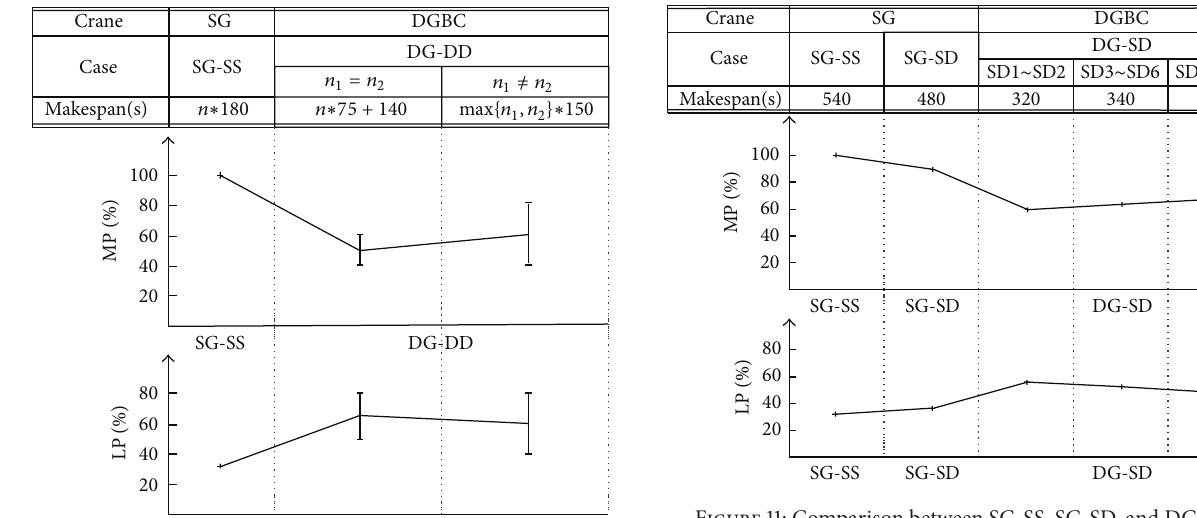
Figure 11: Comparison between SG-SS, SG-SD, and